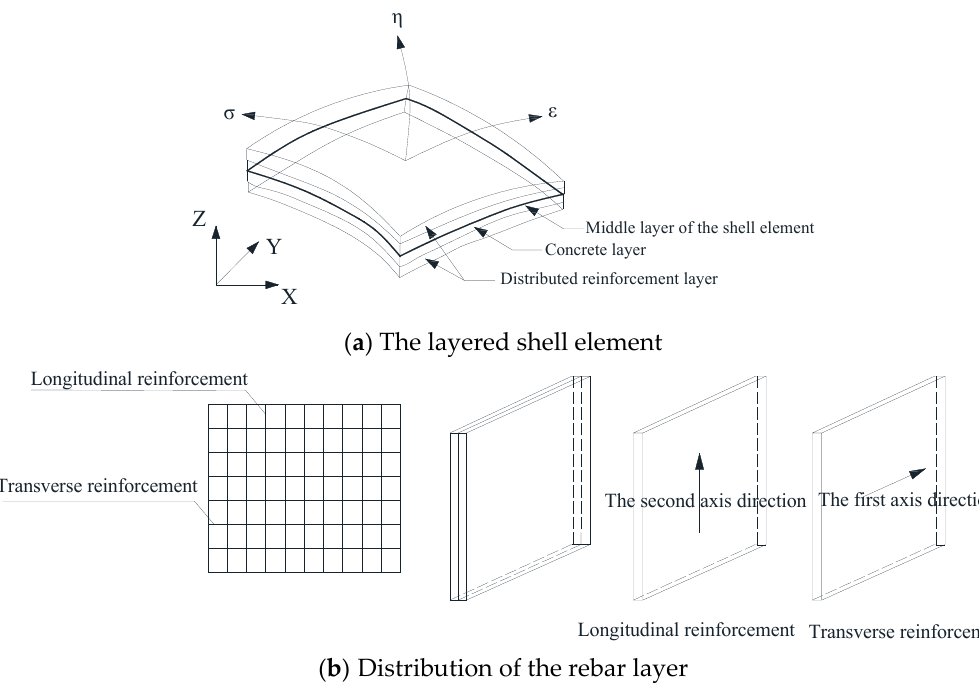
Figure 1. Schematic diagram of layered shell element. Table 1. Parameters of shear wall components.